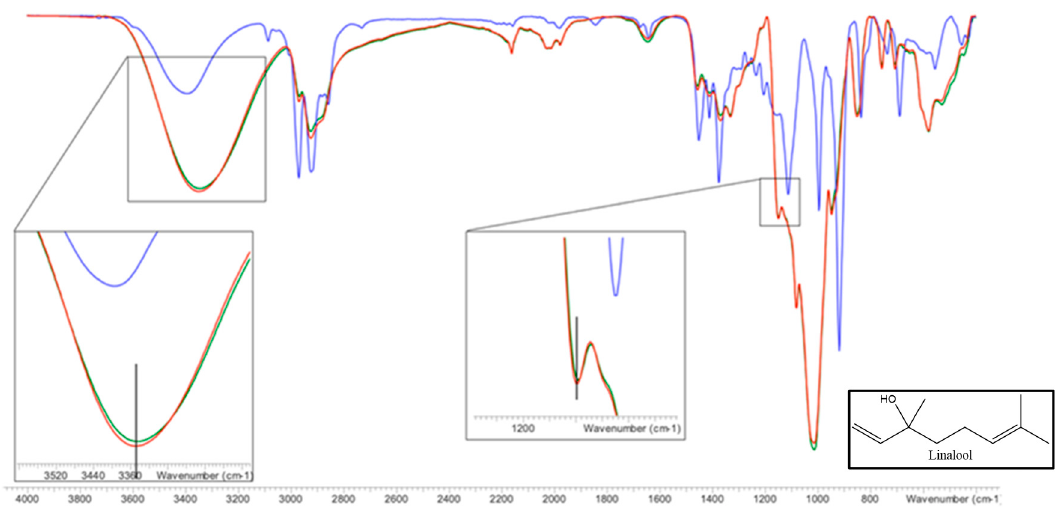
Figure 10. FTIR spectrum of HP- β -CDs (green line), linalool-HP- β -CDs complexes by US (red line), linalool (blue line). The vertical lines indicate the maximum of the HP- β -CDs curve. Inset: linalool chemical structure.